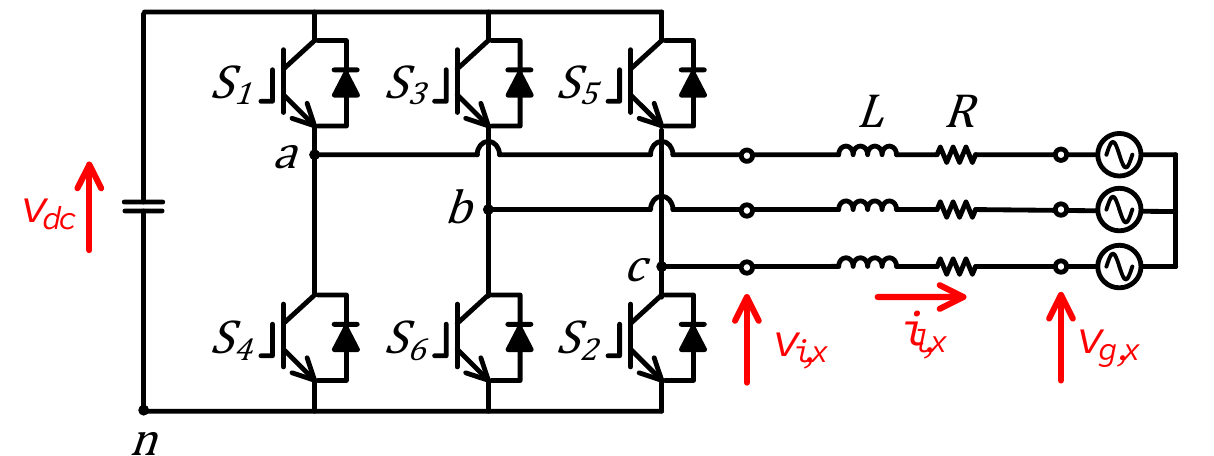
Figure 1. Grid-tie two-level VSI with output L filter.